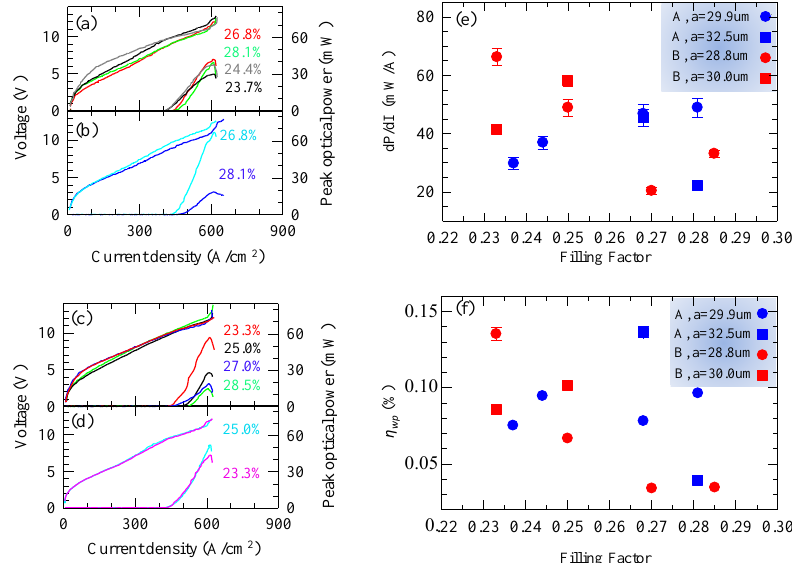
Figure 5. ( a – d ) Power current density (LJ) and voltage current density (VJ) characteristics measured at 10 K, in pulsed mode with a 1% duty cycle, for the whole set of fabricated type A ( a , b ) and type B ( c , d ) resonators. Panel (a) refers to a type A resonator with a = 29.9 µm, panel (b) to a type A resonator with a = 32.5 µm, panel (c) to a type B resonator with a = 28.8 µm and panel (d) to a type B resonator with a = 30.5 µm. Optical power scales have been corrected to take into account the detector collection efficiency and the absorption of the cyclic olefin copolymer cryostat window; ( e , f ) Slope efficiency dP/dI ( e ) and wall-plug efficiency η WP (f) plotted as a function of the filling factor. Red symbols refer to type B samples having a = 28.8 μm (•) and a = 30.0 μm ( ▪ ); blue symbols refer to type A samples with a = 28.8 μm (•) and a = 30.0 μm ( ▪ ).